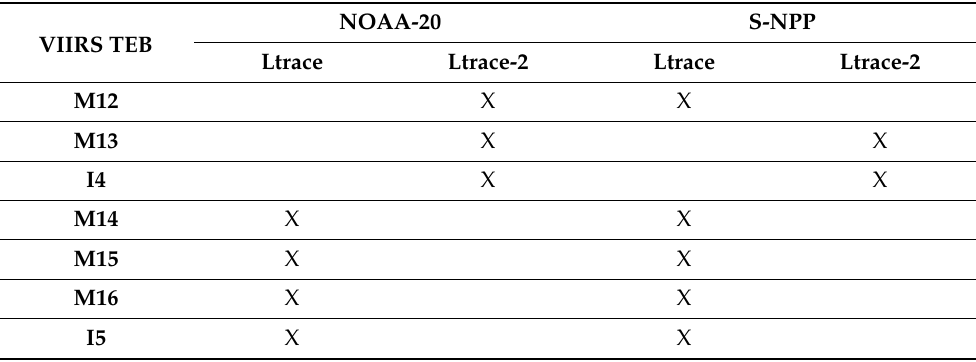
Table 2. WUCD bias correction method applied for individual NOAA-20 and S-NPP TEB bands in the NOAA operational processing since 25 July 2019. The Nominal-F and the WUCD-C methods are reserved for future